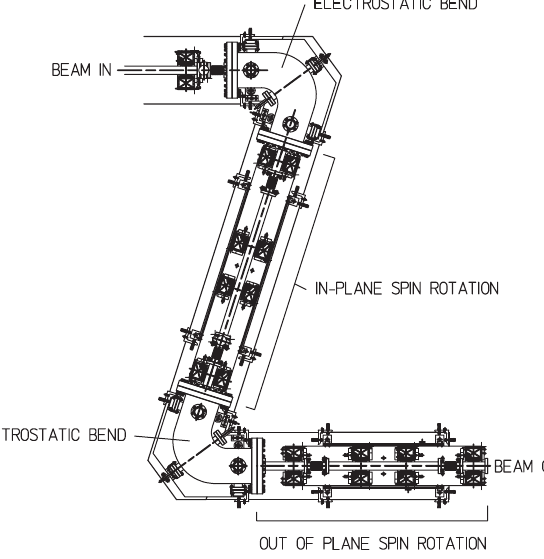
FIG. 2. The Z-style spin manipulator used with the first polar- ized electron